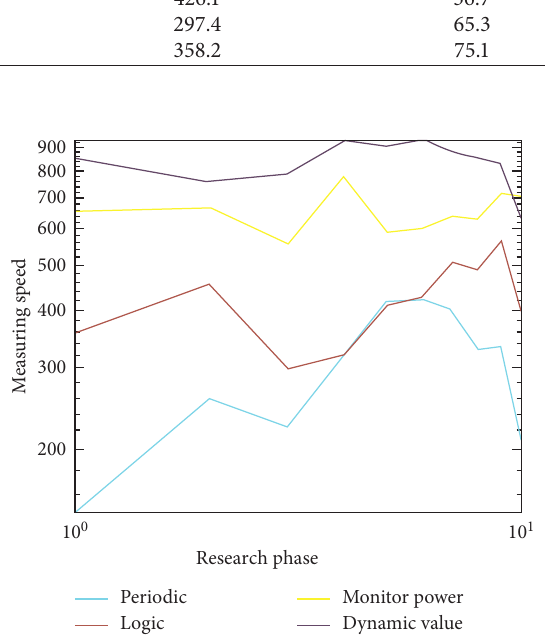
Figure 1: CPLD-based nanoscale grating ruler displacement measurement system increases measurement